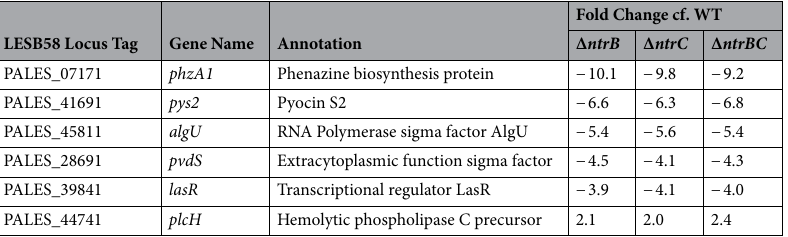
Table 1. Differential expression of selected genes involved in the production of anti-Staphylococcal virulence factors. Gene expression is shown as fold-change (FC) from WT using the ΔΔ Ct method. Dysregulated expression was considered meaningful when FC was greater than ± 2. Data are shown as the mean from three independent experiments each containing three technical replicates.